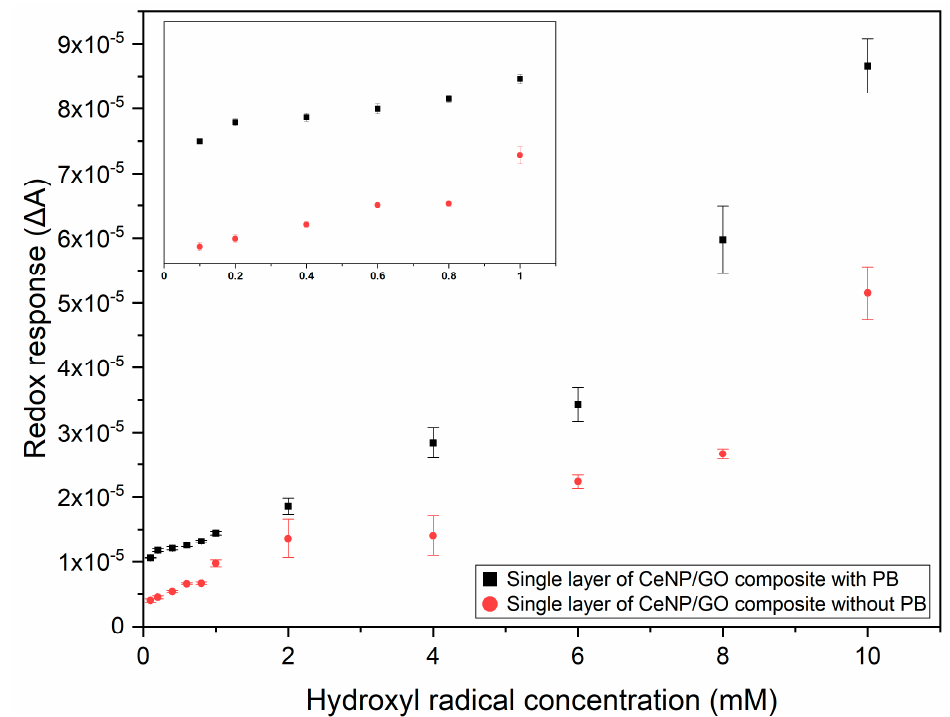
Figure 9. Relationships of the redox response ( ∆ A ) with • OH radical concentrations from 0.1 to 10 mM. The inset is for the radical range of 0.1–1.0 mM.